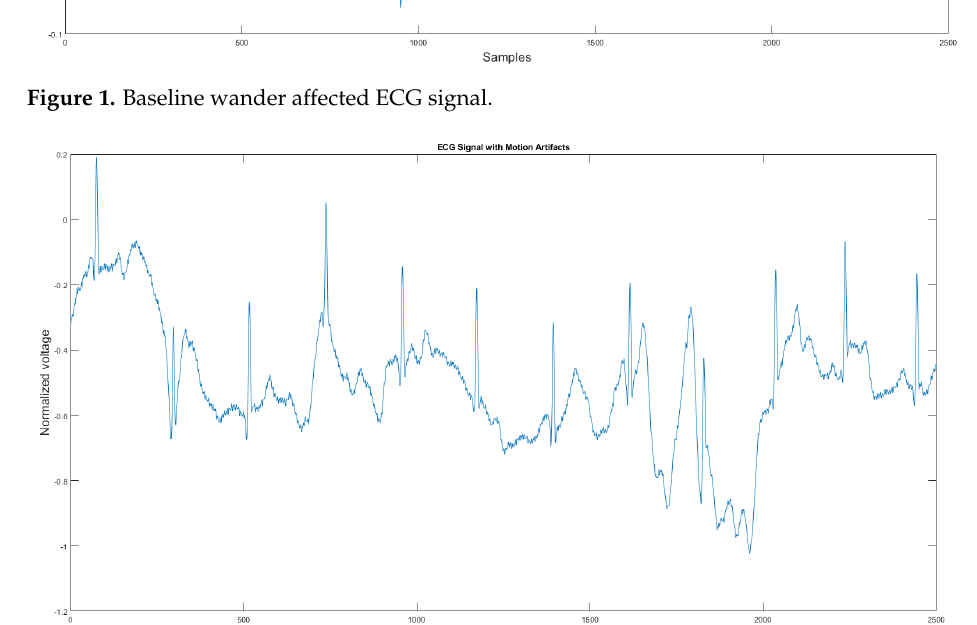
Figure 2. Motion artifact affected ECG